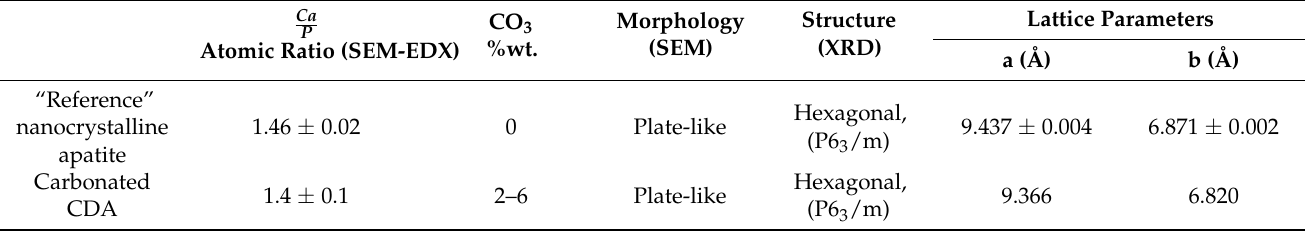
Table 1. Characteristics of the “reference” apatite and carbonated CDA deposited on ACC substrate.